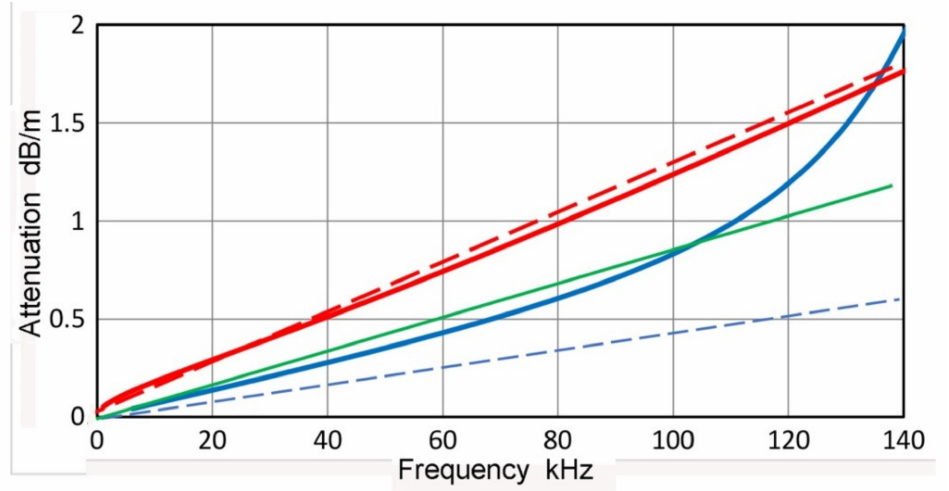
Figure 19. Approximate estimation of α –S o (green curve) and α –A o (red dash line) values using α L and α T . Calculated α –S o (blue curve) and α –A o (red curve) for SM50 steel are also plotted.